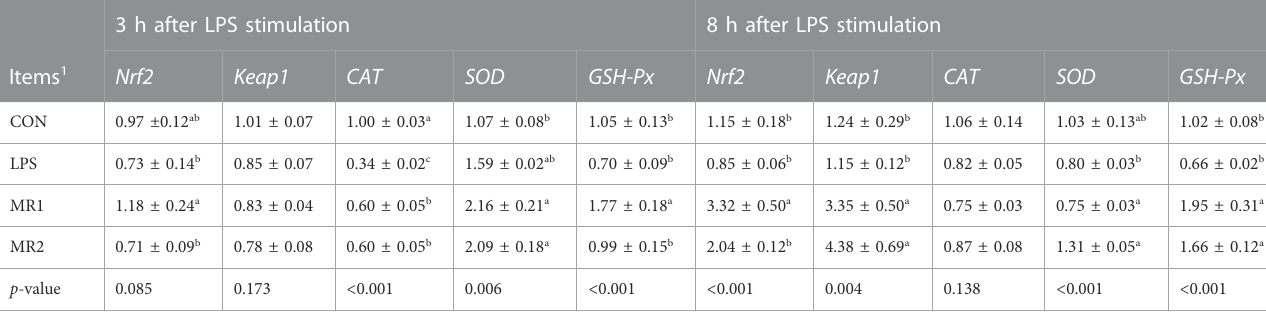
TABLE 9 Effects of dietary methionine restriction on liver mRNA expression of LPS-stimulated broilers (n = 6). 3 h after LPS stimulation 8 h after LPS